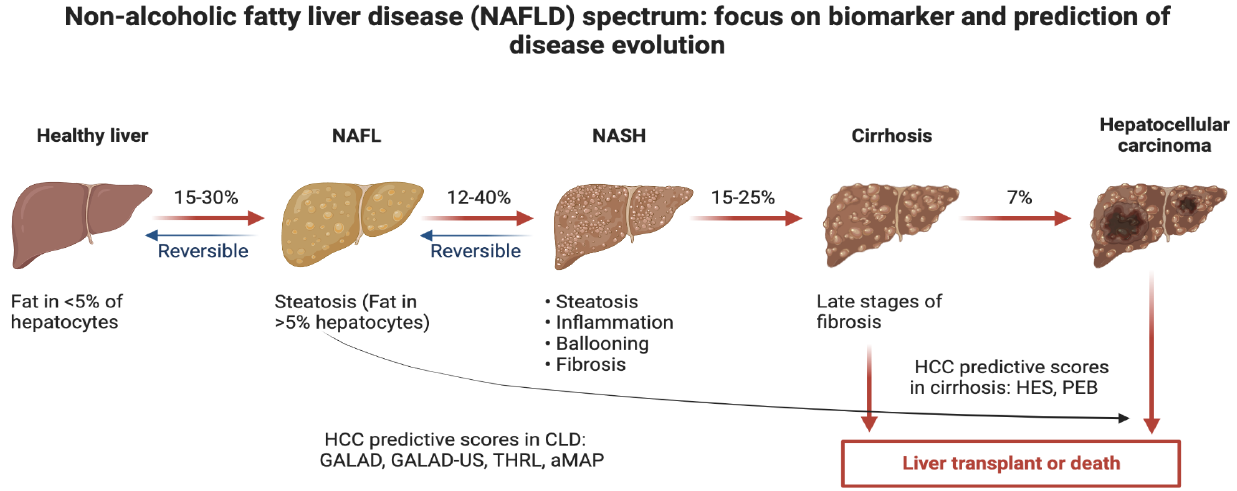
Figure 1. Depiction of a future possible scenario of prognostic scores in the context of hepatocellular carcinoma.